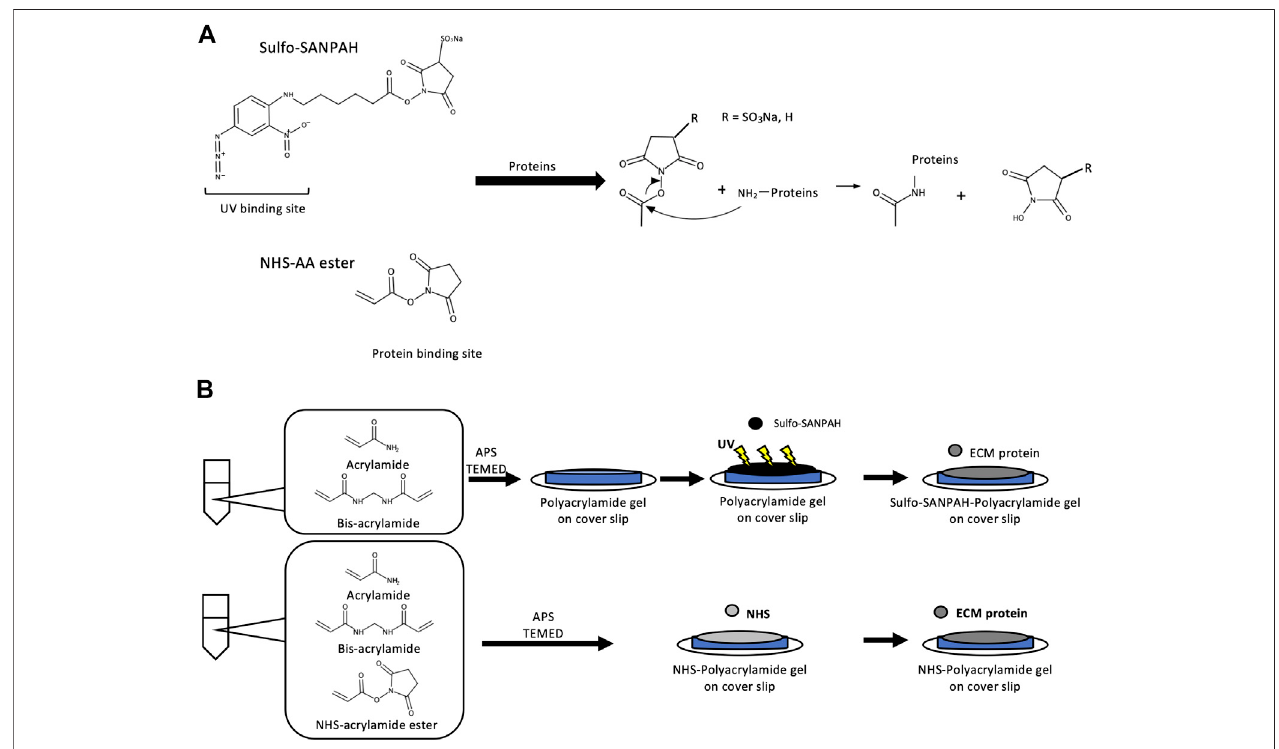
FIGURE 1 | Overview of protein crosslinker action and PA gel preparation (A) When sulfo-SANPAH is used as a protein crosslinker, the ECM protein forms an amide bond with the reactive site of sulfo-SANPAH and indirectly binds to PA. When NHS-AA ester is used as a protein crosslinker, the ECM protein forms an amide bonddirectlywithPA. (B) OutlineofthePAgelpreparationmethod.Whensulfo-SANPAHisusedasaproteincrosslinker,0.5 mLofsulfo-SANPAHsolution(0.2 mg/mL) was applied to the gel surface under 365 nm UV light after polymerization of AA and bis-AA (top) . When NHS-AA ester is used as a protein crosslinker, it is mixed with AA and bis-AA before polymerization (bottom)